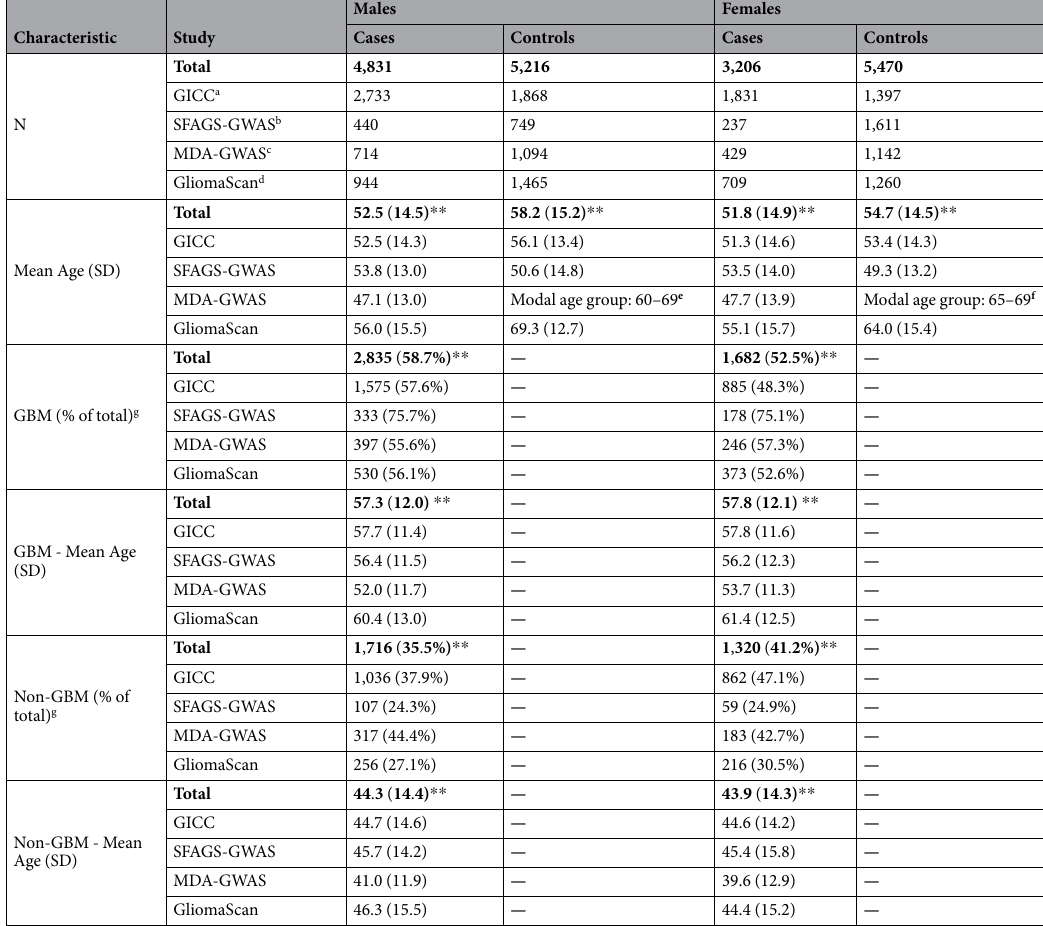
— Table 1. Population characteristics by study and sex. a Data from Glioma International Case-Control Study (GICC; Melin, et al . 4 ); b Data from San Francisco Adult Glioma Study GWAS (SFAGS-GWAS; Wrensch, et al . 12 ); c data from MD Anderson Cancer Center GWAS (MDA-GWAS; Shete, et al . 13 ); d Data from the National Cancer Institute’s GliomaScan (GliomaScan; Rajaraman, et al . 14 ); e Data from CGEMS prostate study (Yeager et al . 35 ). Continuous age is not available, age distribution is as follows 50–59: 12.3%, 60–69: 56.7%, 70–79: 30.7%, 80–89: 0.3%; f Data from CGEMS breast study (Hunter et al . 36 ). Continuous age is not available, age distribution is as follows: 0–54: 4.3%, 55–59: 15.0%, 60–64: 23.6%, 65–69: 27.5%, 70–74: 19.0%, 75–99: 10.7%; g Histology information not available for all cases and frequencies may not add to 100%. ** Differs between included